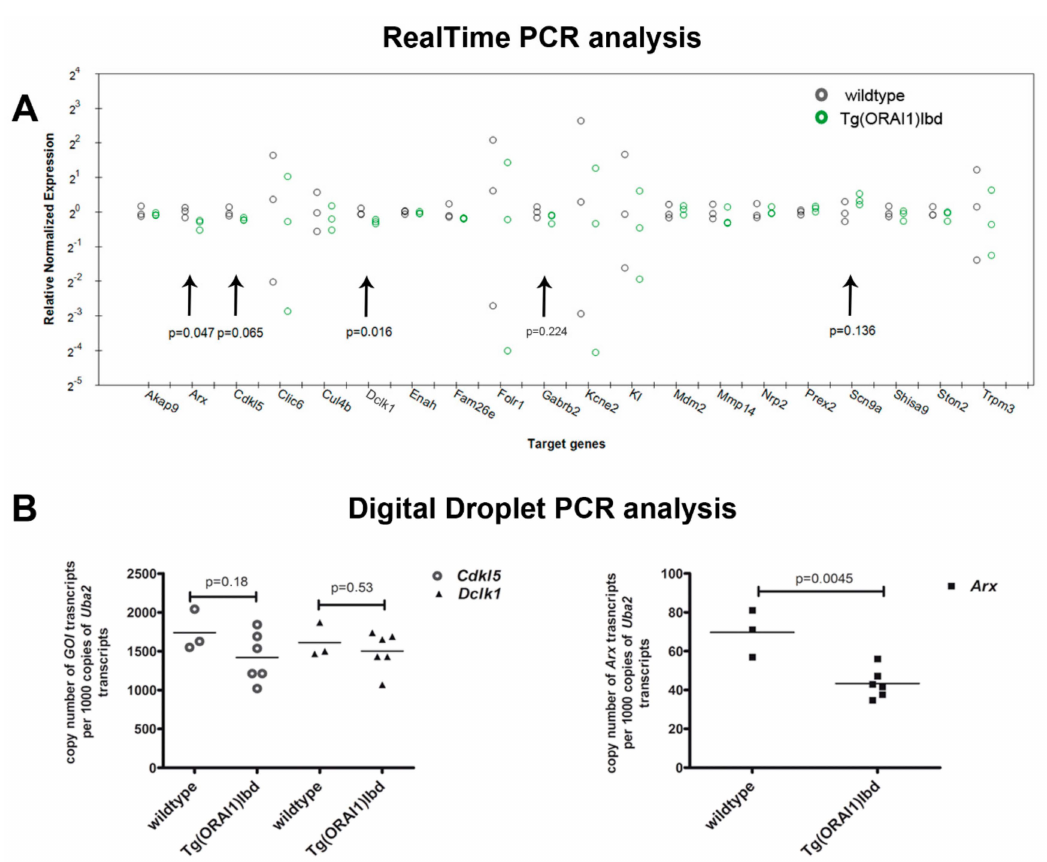
Figure 3. Expression profile of selected genes in hippocampi of the tested mouse variants. ( A ) Rea-time PCR analysis of the selected genes that was based on RNAseq data. The results are presented as scatter plot, each circle corresponds to one animal. Black circle corresponds to each tested wild-type